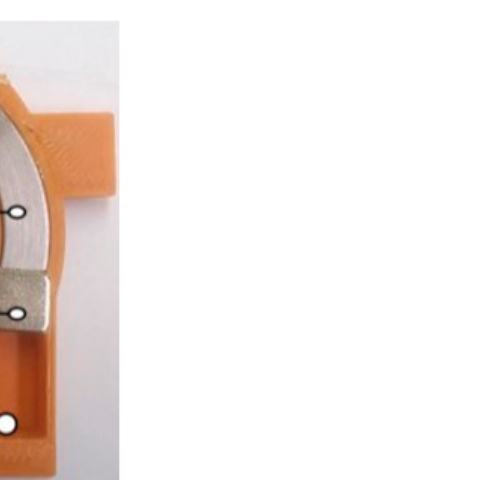
Figure 12. Optical fiber current sensor based on 1.5 g hyperboloid magnetostrictive composite material.